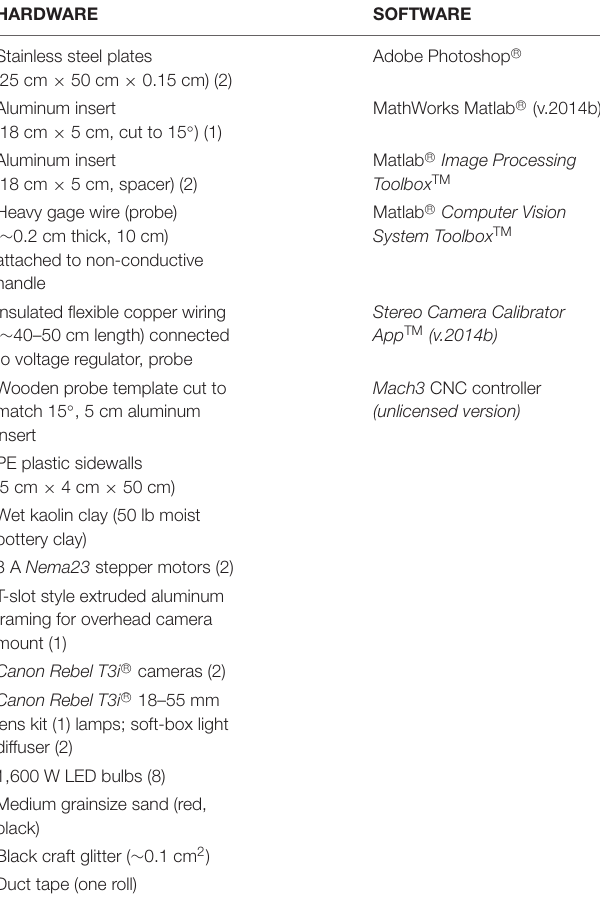
TABLE 1 | List of materials used to conduct physical experiments and the necessary software for processing the data. HARDWARE